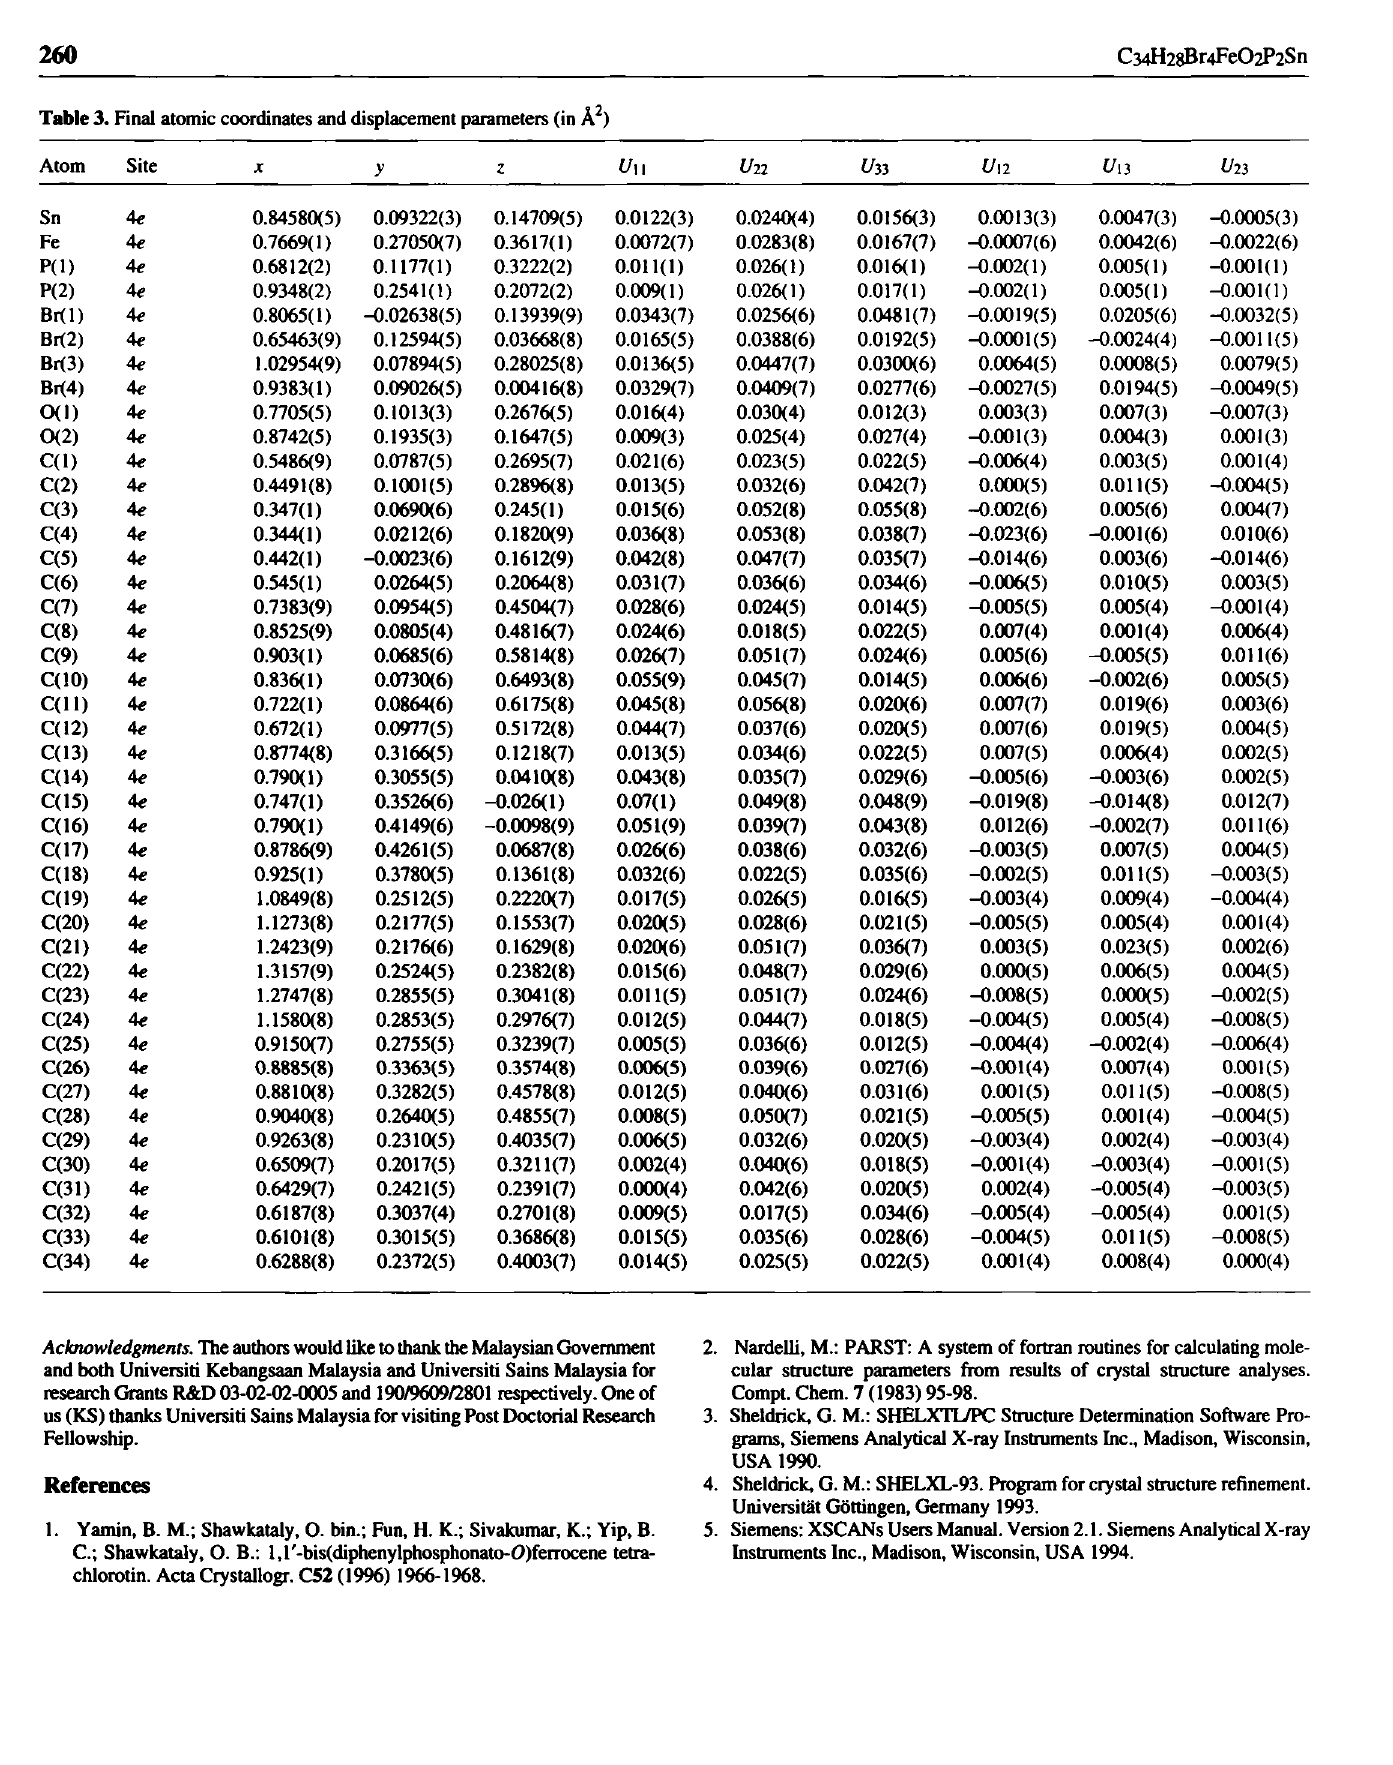
Table 3. Final atomic coordinates and displacement parameters (in